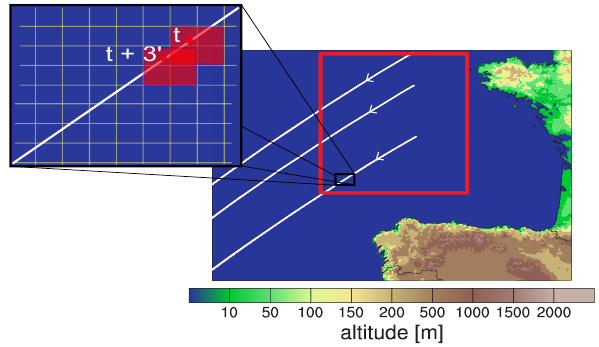
Figure 2. 2km simulation domain of 1160km × 800km showing three prescribed ship routes oriented from northeast to southwest. A schematic of the distribution of the ship emissions along the 2km × 2km grid is given inside the black box. The emissions are distributed at a 3min (1.5min) interval within four adjacent grid boxes along the ship’s route for ships moving at 5 or 10ms − 1 (20ms − 1 ). The red box displays the ship track domain used in Figs. 3–7 and 9. (Note that the ship plume locations shown in these figures are determined by the relative motion between the ships and the horizontal wind.) Table 2. Summary of ship emission specifications as prescribed in the simulations. Prescribed SO 2 and PM mass fluxes based on the literature (Hobbs et al., 2000) are given together with prescribed size distributions and ship’s speed ( v ship